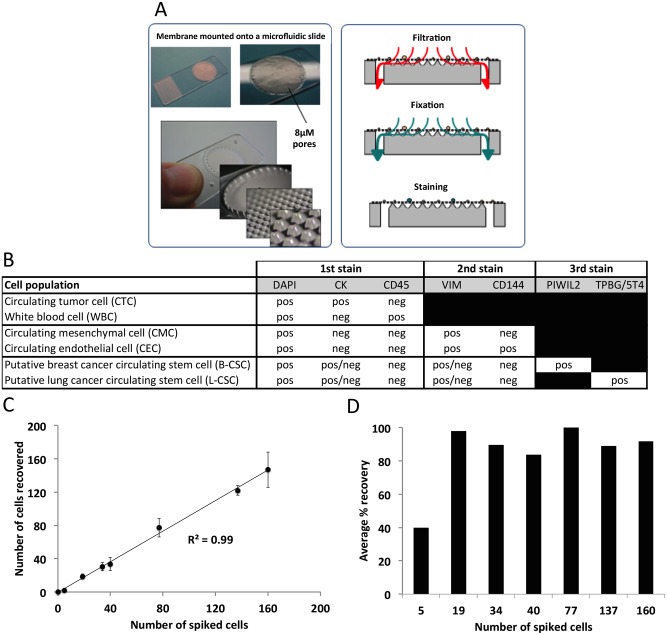
Assay development and cell recovery experiment.
A. Design of the microfluidic filter device and the schematic overview of the processing steps for capture and detection of circulating rare cells, B. Biomarkers and immuno-phenotypes of circulating rare cells identified through the sequential staining procedure, C. Average percent recovery after spiking known numbers of H226 lung cancer cells into healthy blood, D. Scatter plot showing the number of H226 spiked cells and the number of cells recovered.